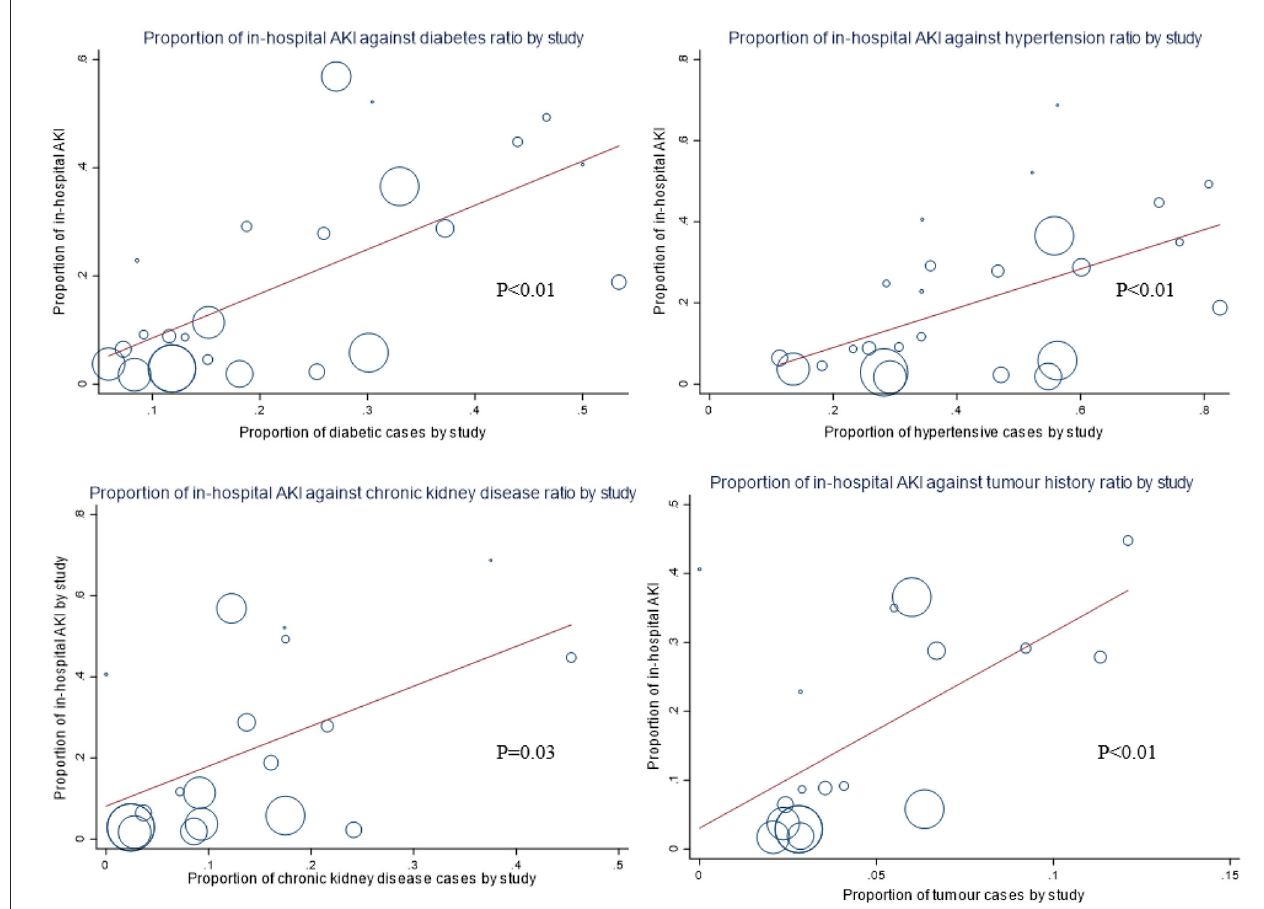
FIGURE 4 | Underlying prevalence of chronic diseases and incident acute kidney injury during COVID-19. Each percentage increase in the population prevalence of underlying diabetes, hypertension, chronic kidney disease, and tumor history was associated with 0.82, 0.48, 0.99, and 2.85% increase in incident in-hospital acute kidney injury (AKI),